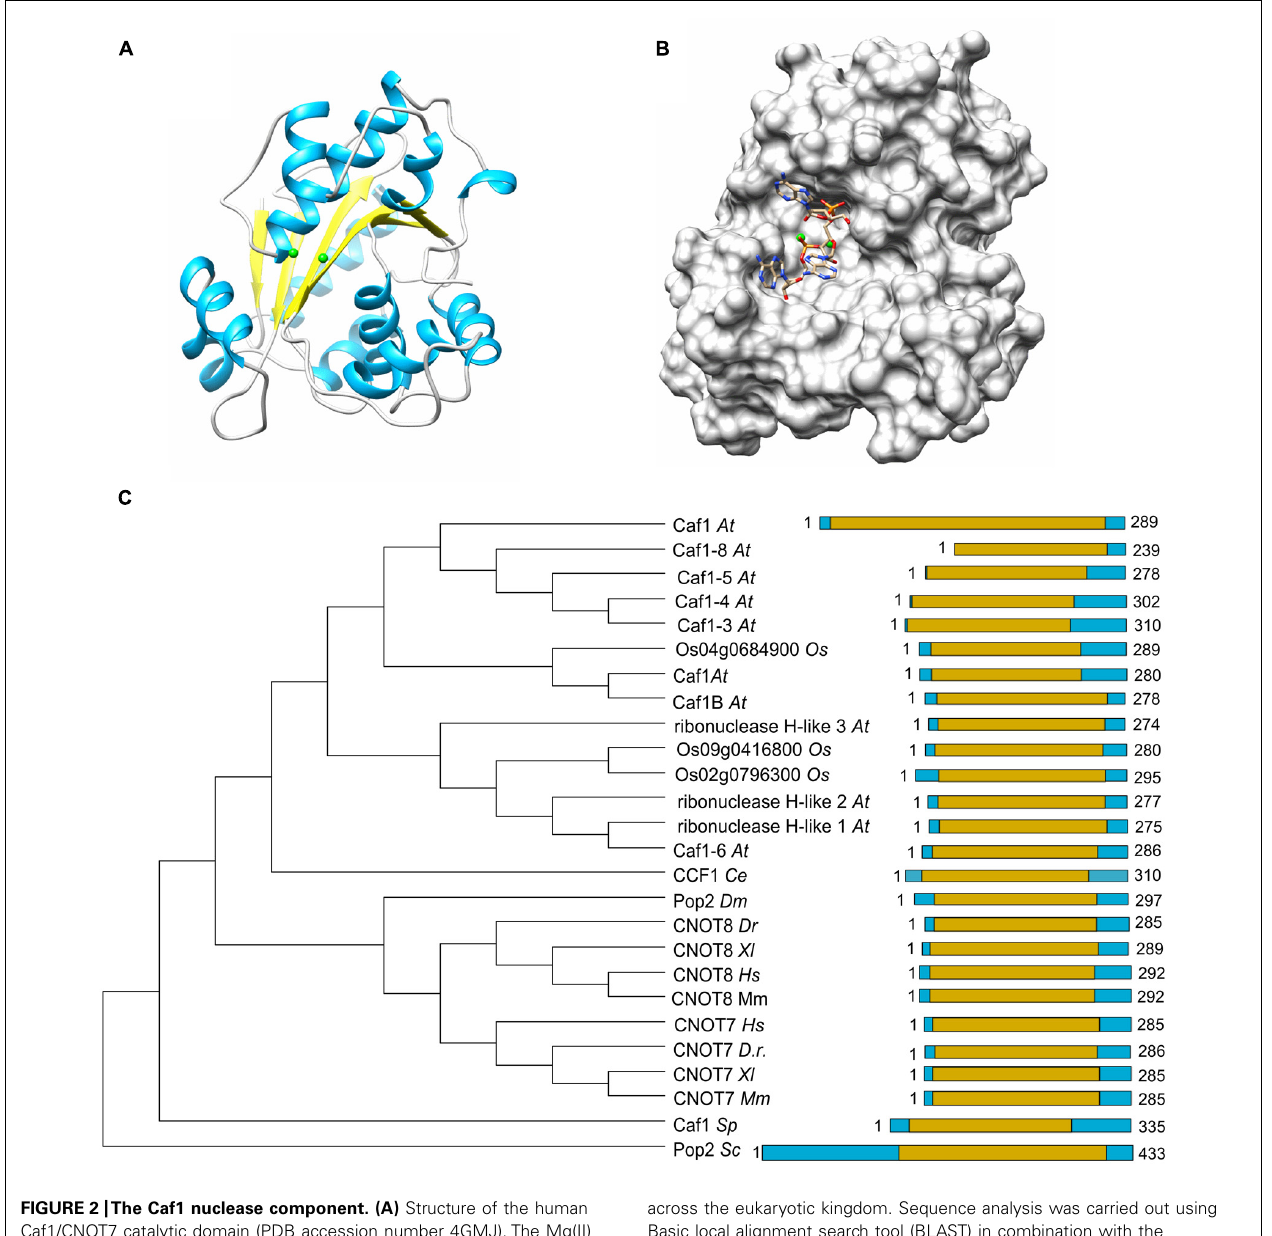
FIGURE 2 |The Caf1 nuclease component. (A) Structure of the human Caf1/CNOT7 catalytic domain (PDB accession number 4GMJ). The Mg(II) ions located in the active site are indicated in green; α -helical regions, blue; β -strands, yellow. (B) Model of poly(A) binding by human Caf1/CNOT7. The model was derived from superposition the structure of the PARN deadenyase in complex with RNA (PDB accession number 2A1R). The Mg(II) ions located in the active site are indicated in green. Structures were visualized using the UCSF Chimera package (http://www.cgl.ucsf.edu/ chimera; Pettersen etal., 2004). (C) Evolutionary conservation of Caf1